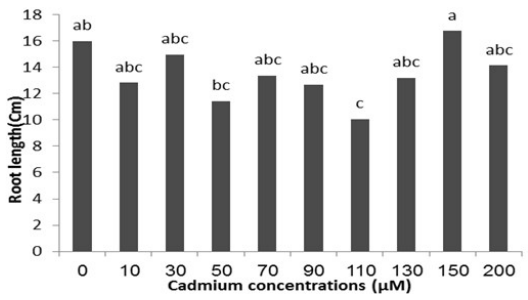
Fig. 2 . Effects of cadmium on root length of Brassica napus